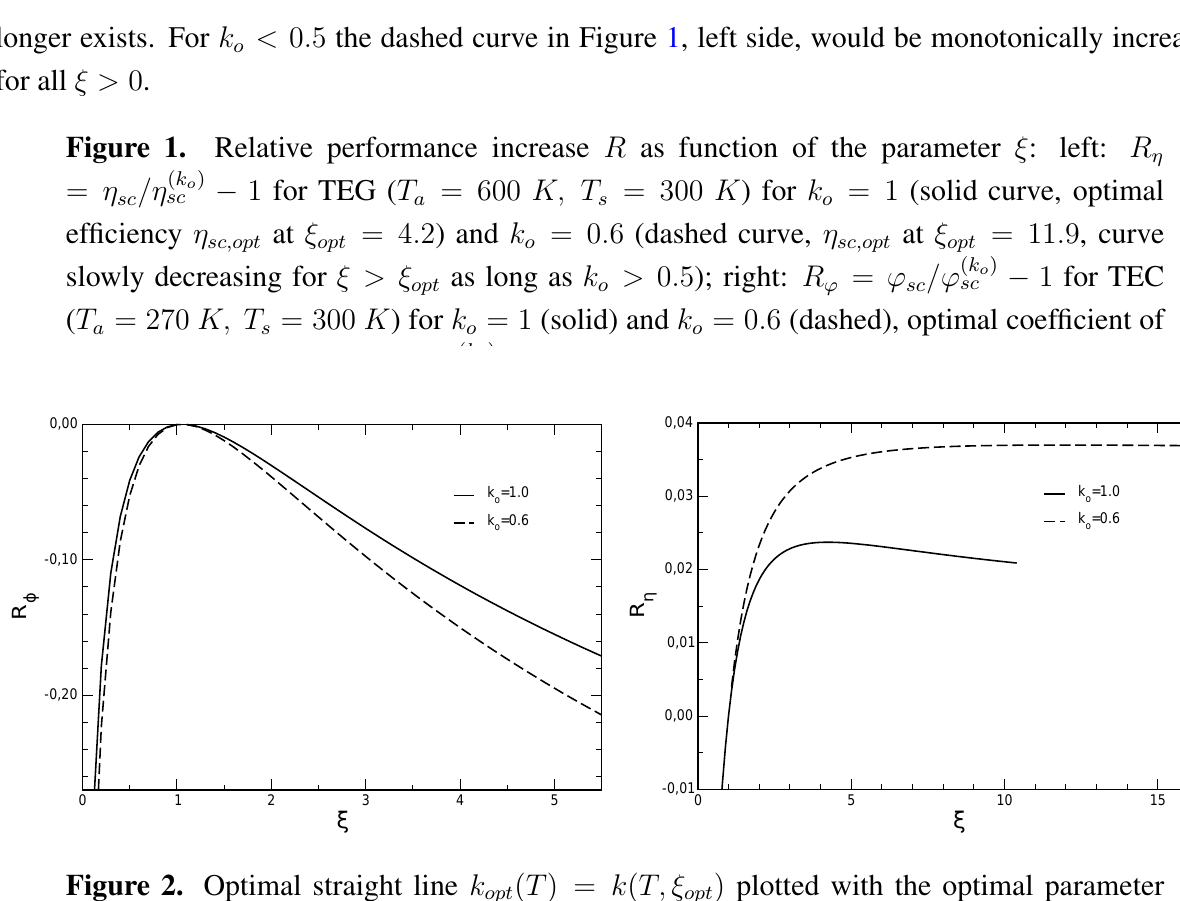
Figure 2. Optimal straight line k ξ derived from Figure 1: left (TEG): ξ opt k = 0 . 6 (blue); right (TEC): ξ o k = 10 , with ξ o